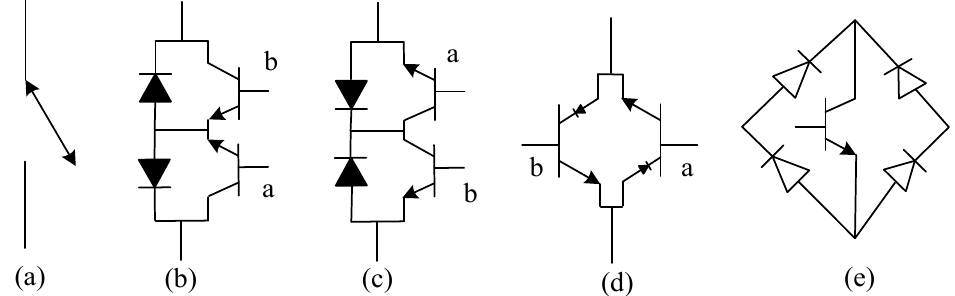
Figure 15. Schematic implementation of ( a ) the ideal switch and the different possible implementation of the four quadrant switch with ( b ) two IGBTs each with an antiparallel diode connected anti-serially in common emitter configuration ( c ) two IGBTs each with an antiparallel diode connected anti-serially in common collector configuration ( d ) two reverse biasing IGBTs connected in antiparallel configuration and ( e ) diode bridge configuration with one IGBT [70].